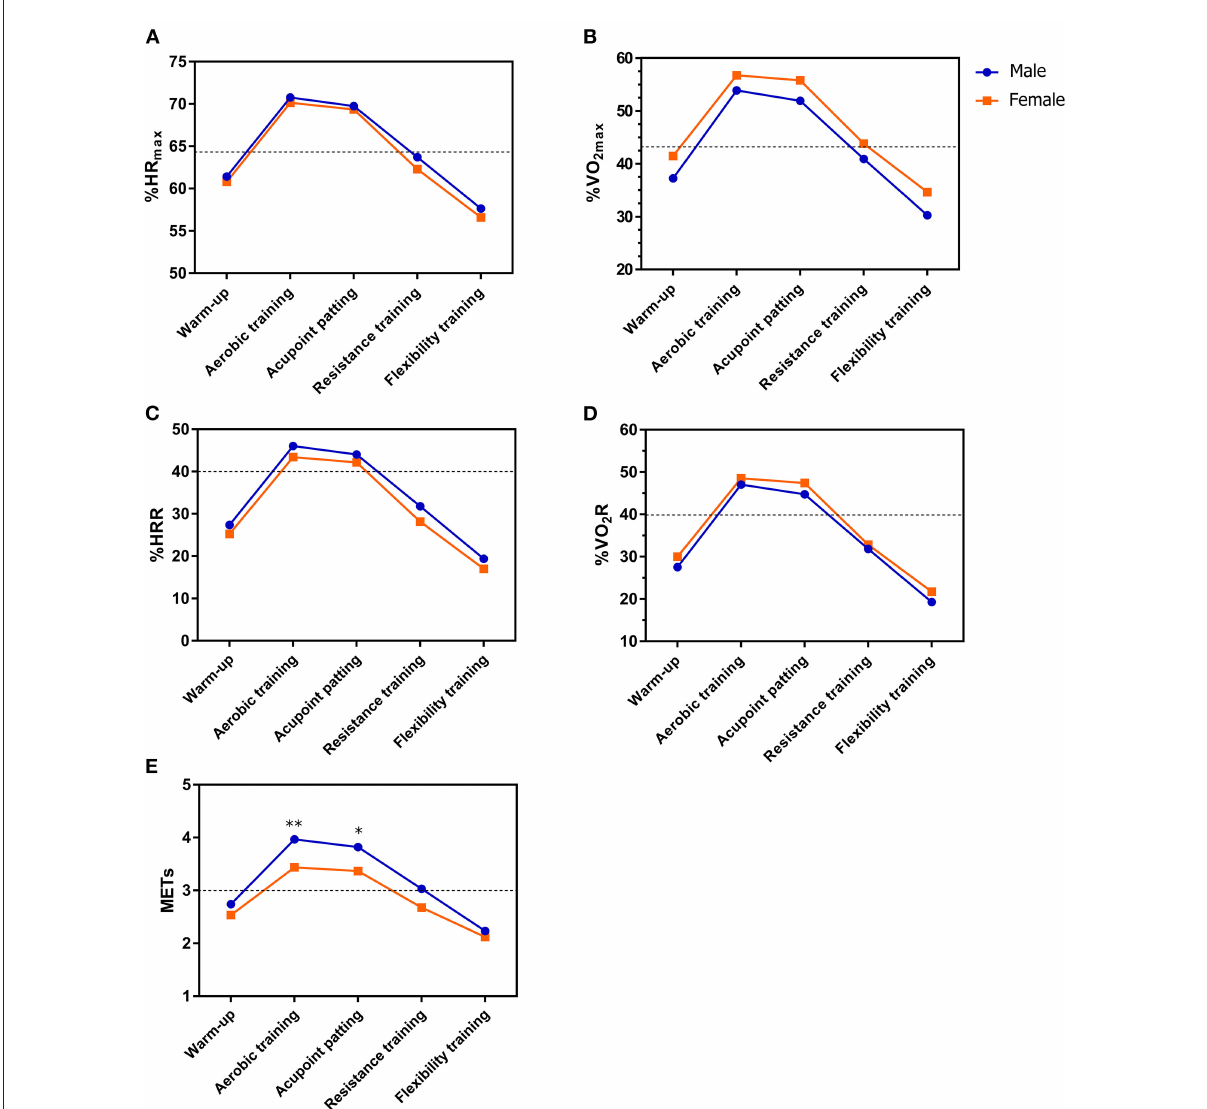
FIGURE5 The exercise intensity of X-CircuiT in different sex groups. (A) Shows the peak heart rate percentage (%HR peak ); (B) Shows the peak oxygen uptake percentage (%VO 2peak ); (C) Shows the heart rate reserve percentage (%HRR); (D) Shows the oxygen intake reserve percentage (%VO 2 R); and (E) Shows metabolic equivalent (METs). The dotted lines are the medium intensity exercise (lower line) or high intensity (higher line) exercise boundary. * Indicates the difference of the corresponding stage between groups p < 0.05; and ** indicates the difference between groups p < 0.01 (an independent sample t